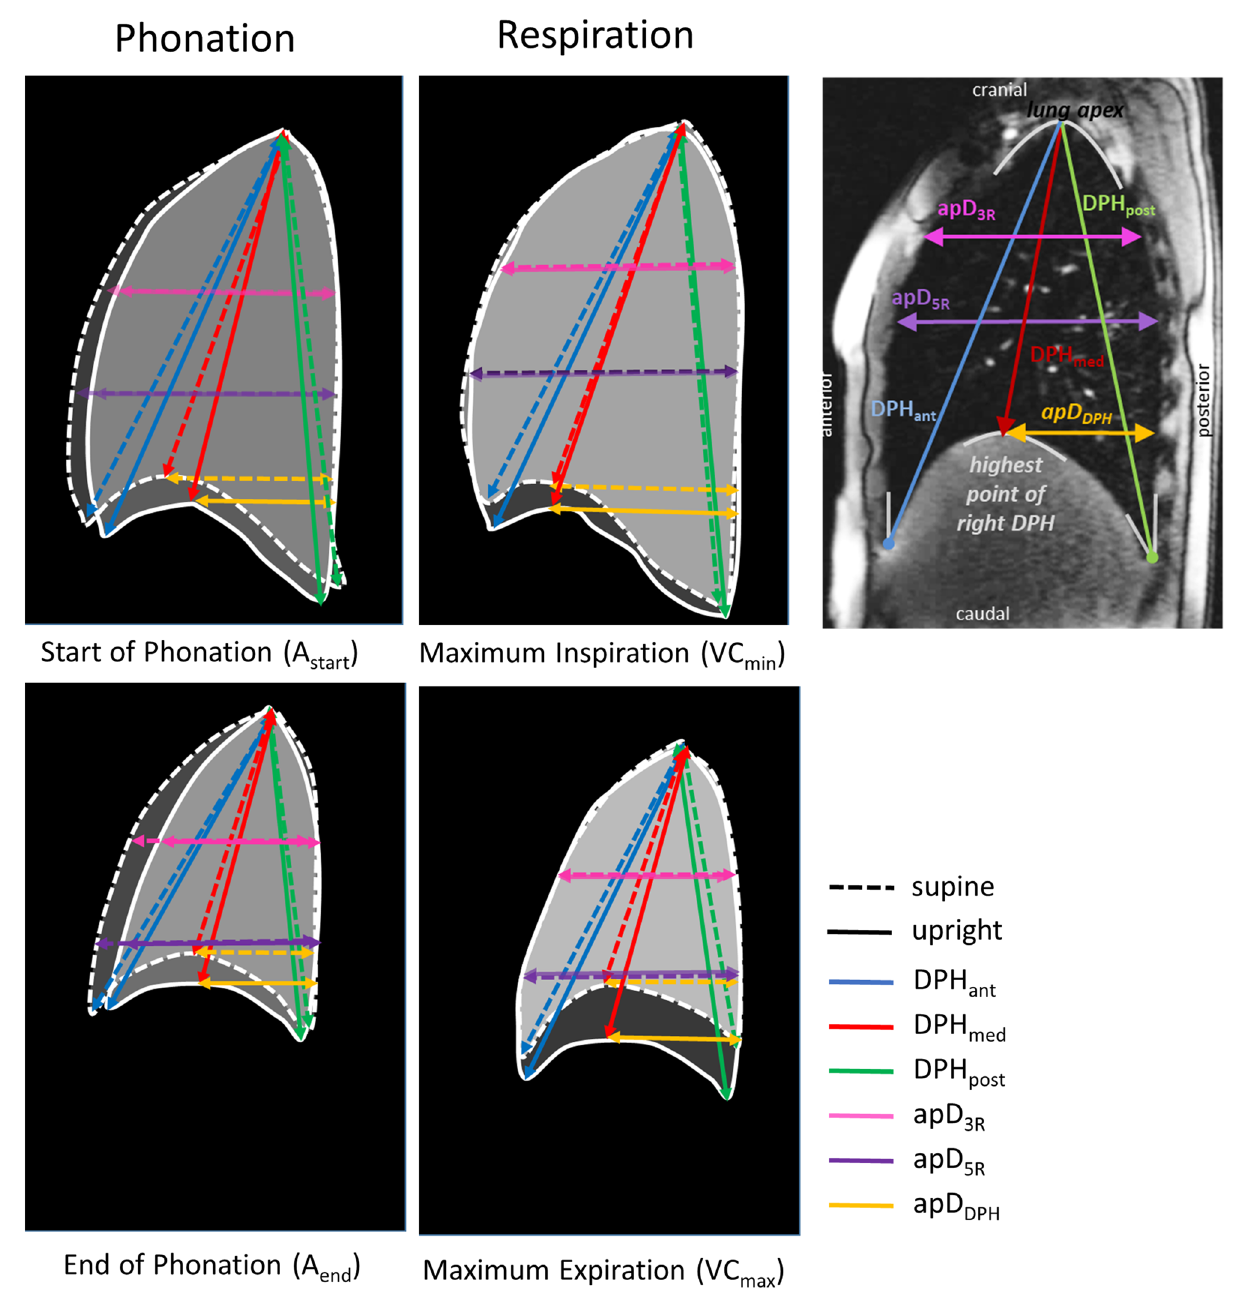
Figure 9. Exemplary visualisation of differences in lung dimensions of subject 3 derived from MRI data at the start and end of phonation of A4 as well as maximum inspiration and expiration in the upright and supine positions. The dimensions of the right lung in sagittal cross-section are shown as a grey area on a black background and differentiated for the upright and supine body positions based on the outline (dashed = supine, solid = upright). Measured distance parameters are displayed in different colours according to Fig.